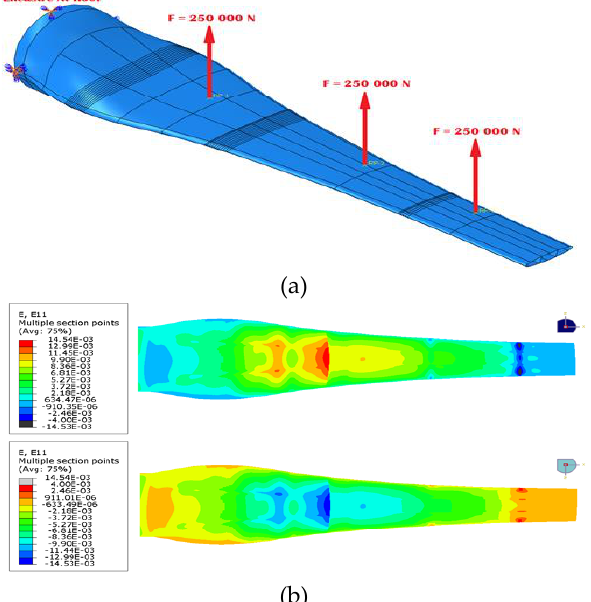
Fig. 13. FE model. (a) loading conditions, (b) example of predicted upper and lower surface strains .